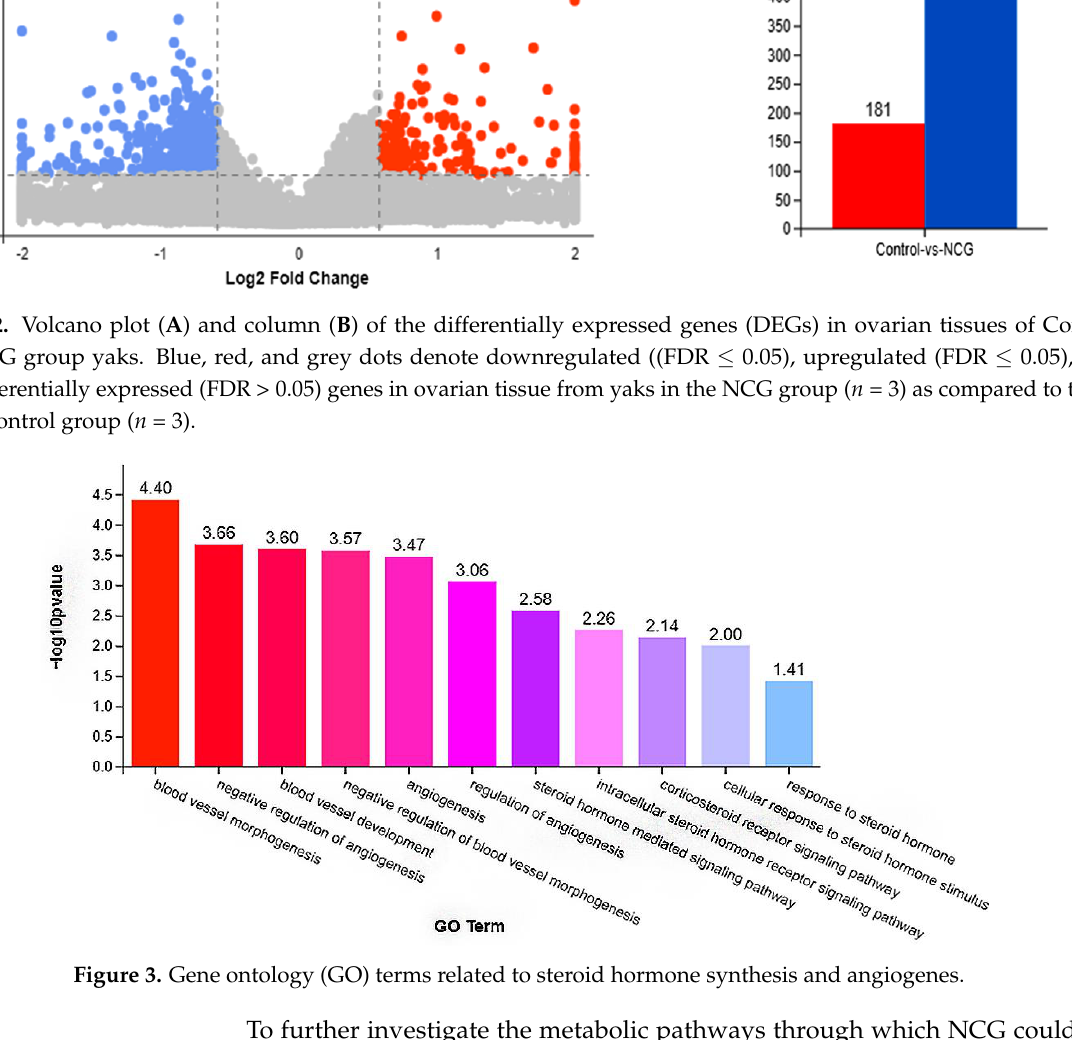
Figure 4. The expression profiles of genes related to steroid hormone metabolism, cholesterol syn- thesis, and angiogenesis as measured by RNA-Seq and represented in a heat map. The differences in gene expression levels are expressed in different colours, as illustrated in the legend.